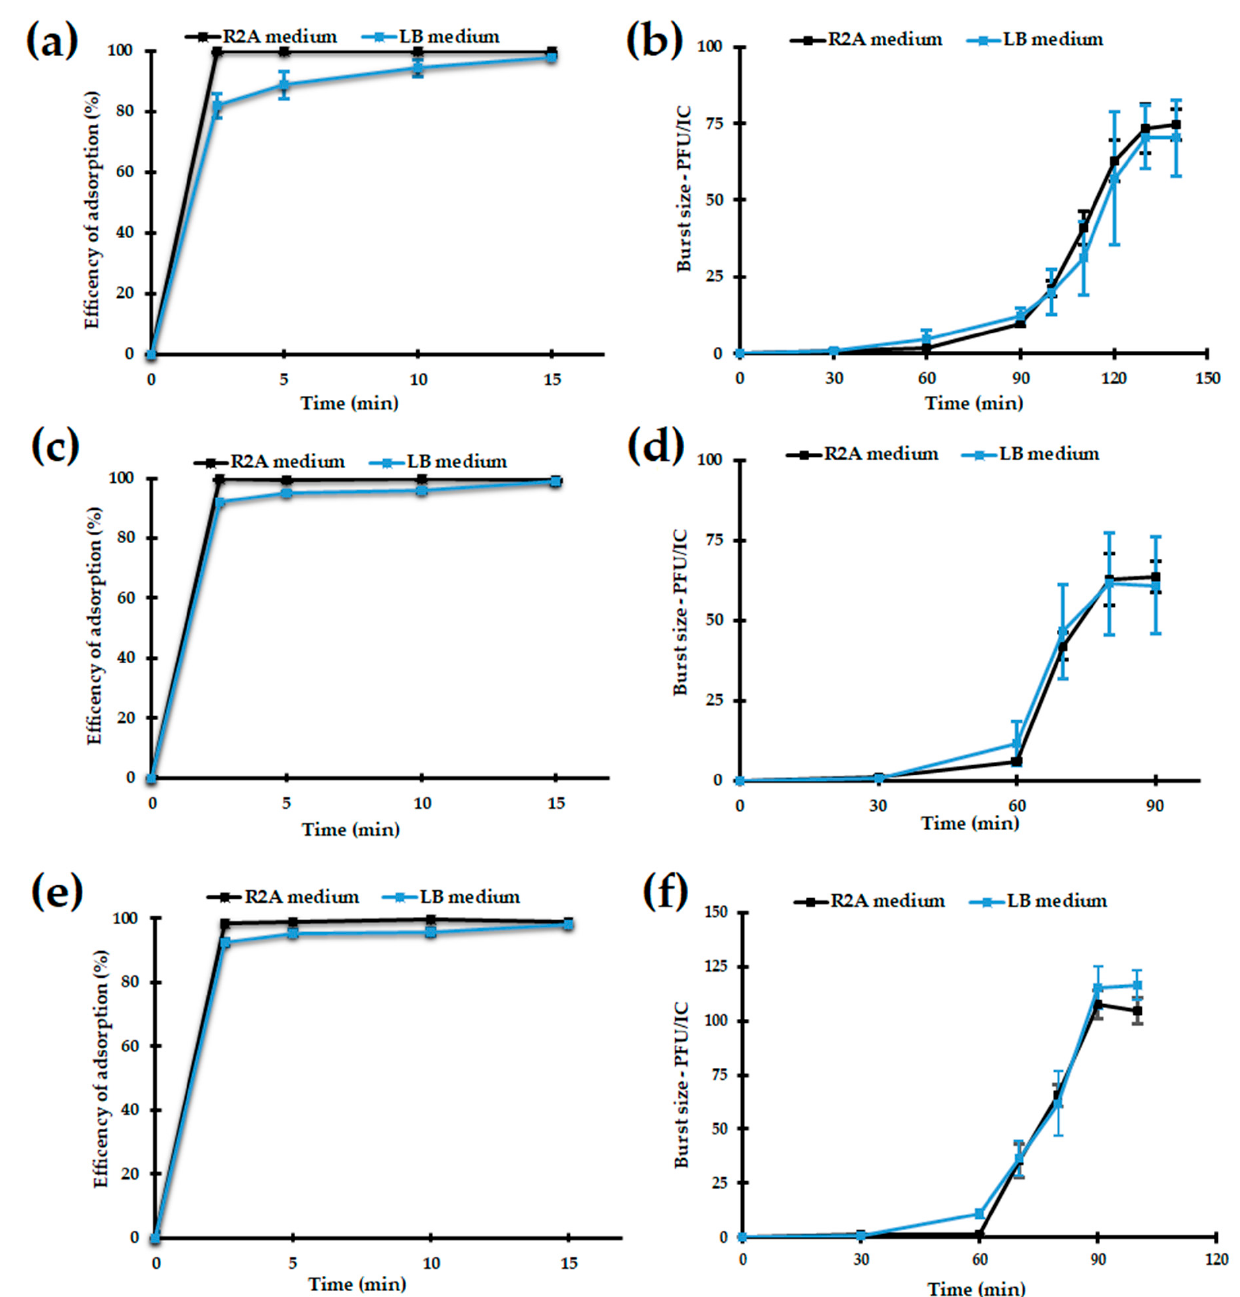
Figure 3. ( a , b ) Bolek, ( c , d ) Lolek, and ( e , f ) Tola phage adsorption to the bacterial cells and one-step growth curves in R2A and LB media.